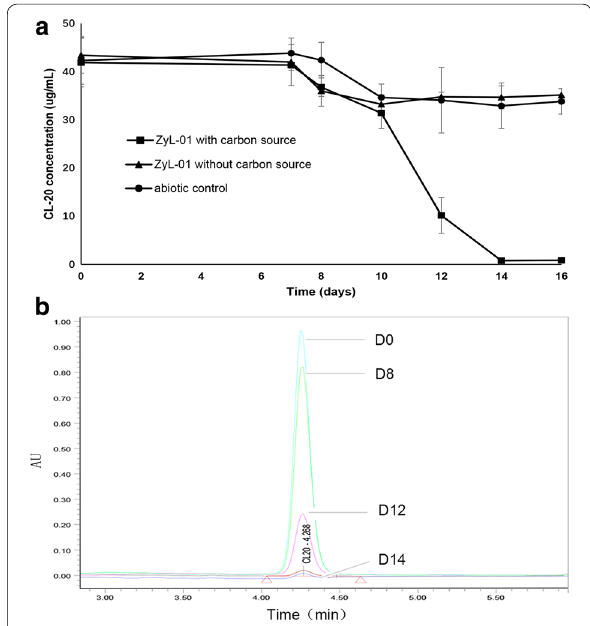
Fig. 4 Biodegradation of CL-20 in production effluent by ZyL-01, CL-20 concentration changing in three groups ( a ), CL-20 Liquid chromatograms in ZyL-01 with carbon source group ( b )